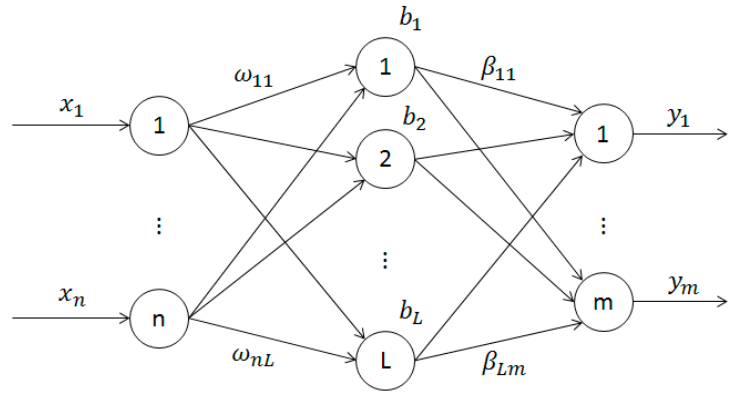
Figure 1. The network structure of the extreme learning machine model.